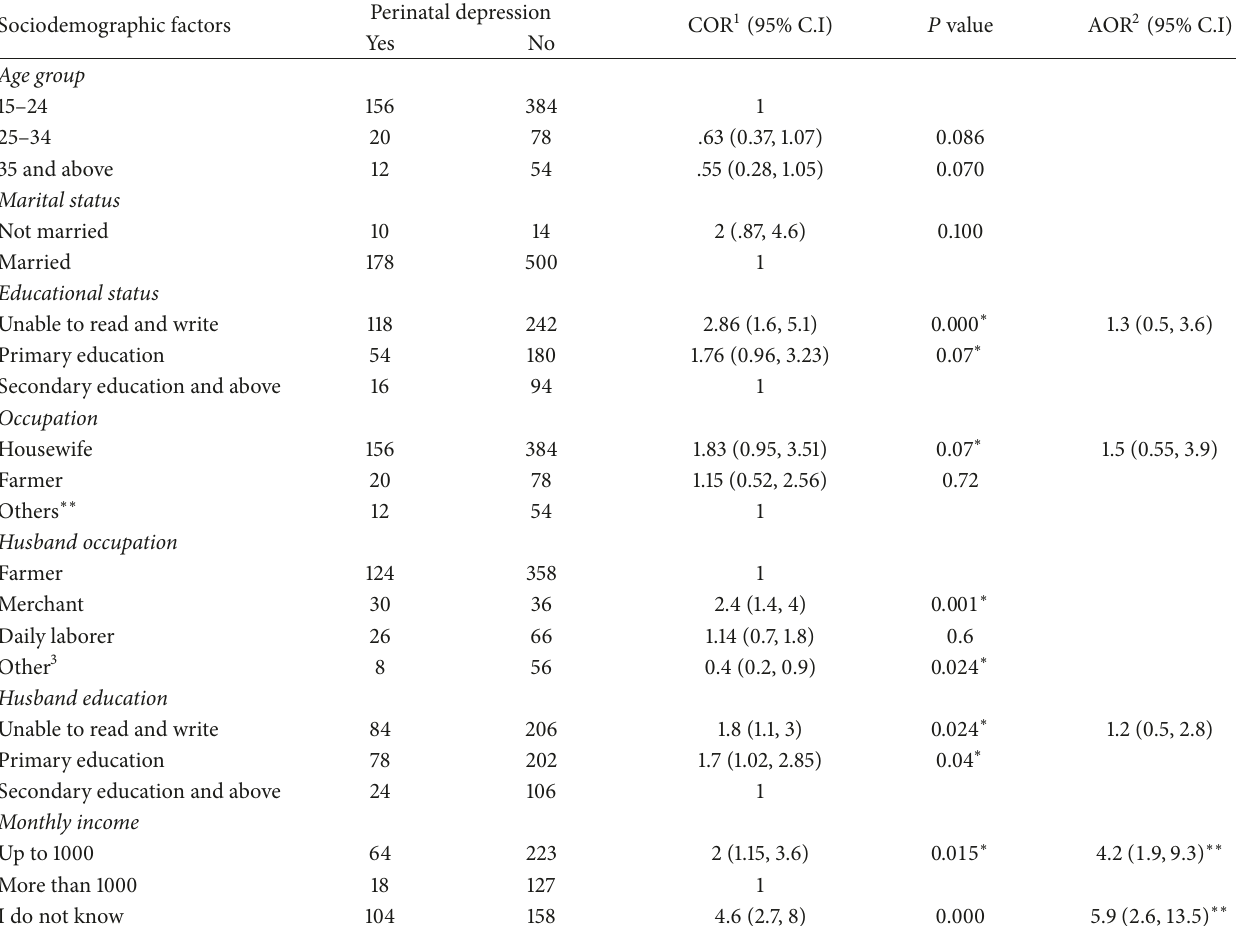
Table 3: Analysis of Sociodemographic factors of participants associated with perinatal depression, Arba Minch Zuria District, Ethiopia, March,